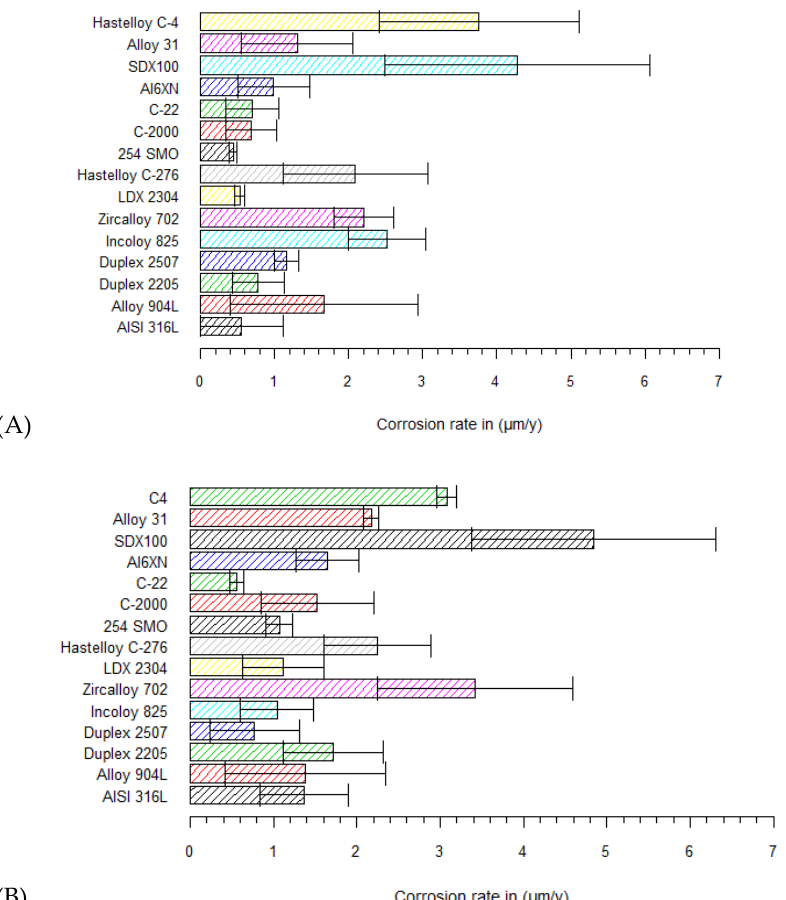
Figure 5. Uniform corrosion rates calculated by Tafel extrapolation in ( A ) pH 12.5 with 1 M Cl − ; and ( B ) pH 13.5 with 1 M Cl − .